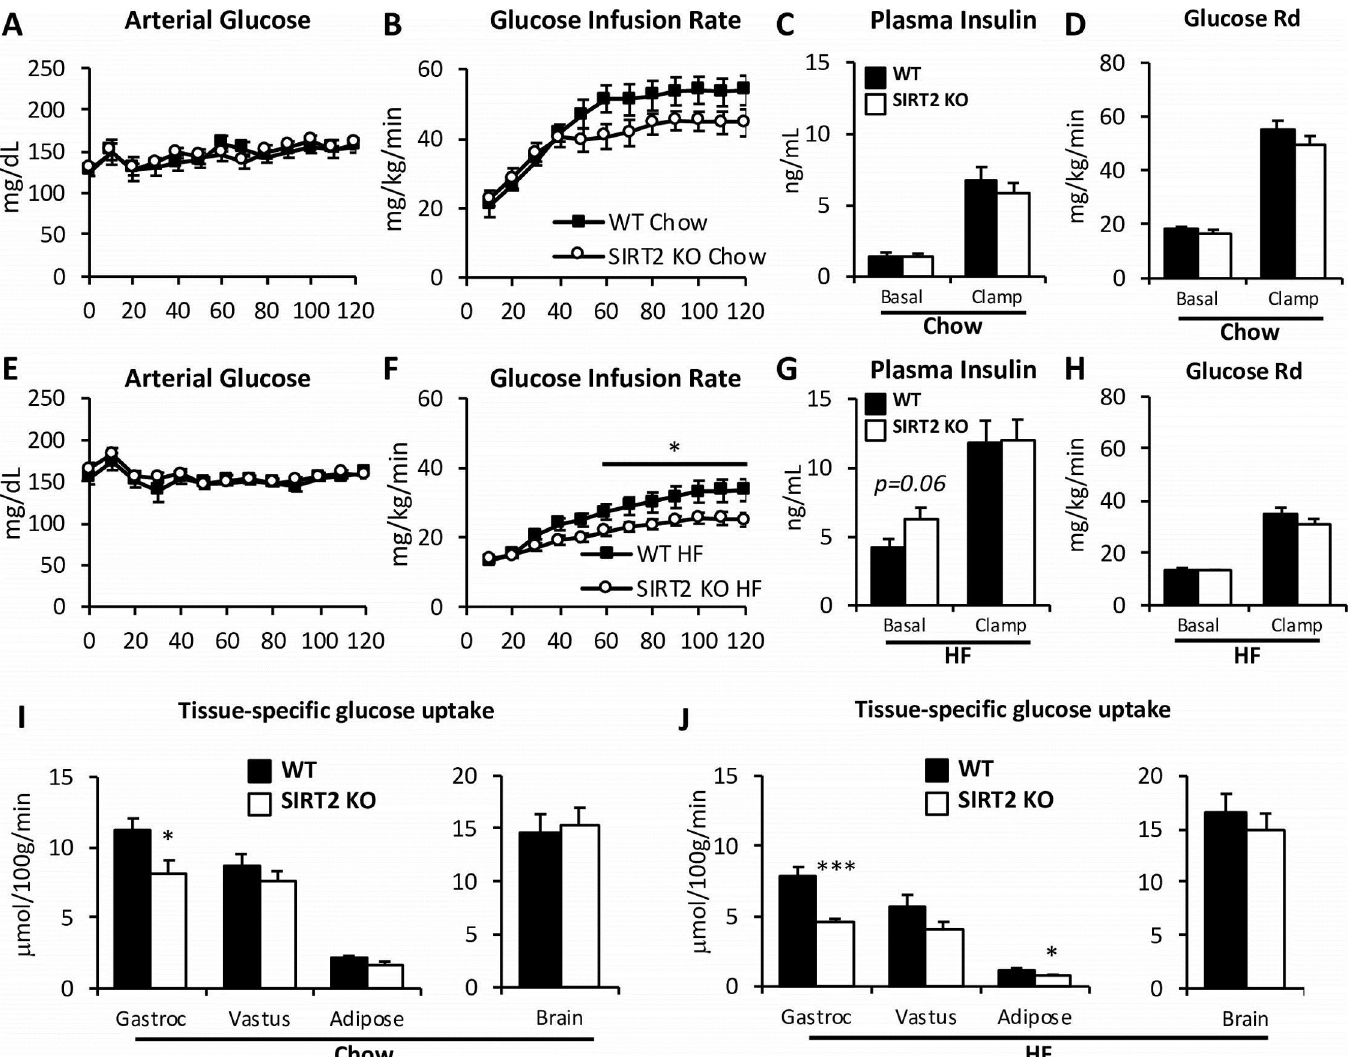
Fig 4. SIRT2 KO mice exhibit muscle insulin resistance during the hyperinsulinemic-euglycemic clamp. A, E : Blood glucose was monitored throughout the clamp at 10-min intervals by sampling from the arterial catheter. Blood glucose was maintained at euglycemia ( * 150 mg/dL) in both chow-fed ( A ) and HF-fed ( E ) mice. The GIR in the venous catheter needed to maintain euglycemia in chow-fed (B) or HF-fed ( F ) mice. Plasma insulin levels at baseline and during the clamp in chow ( C ) or HF-fed mice ( G ). Rd, rate of glucose disappearance, in chow-fed ( D ) or HF-fed ( H ) mice, determined by administration of [3-3H]glucose. Rg in gastrocnemius, vastus lateralis, white epidydimal adipose tissue, and brain is determined by the administration of nonmetabolizable 2[14C]deoxyglucose in chow-fed ( I ) or HF-fed ( J ) WT and SIRT2 KO mice. (n = 7-13/group, see Table 1). Black bars: WT; open bars: SIRT2 KO. For clamp data of weight-matched HF subgroup, see Table 1 and Fig 8.